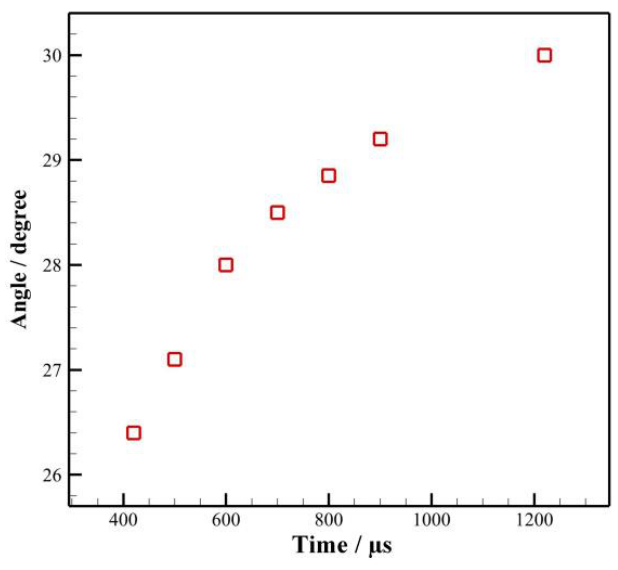
Figure 4. Change curve of the ramp shock tail angle with time during the recovery process.